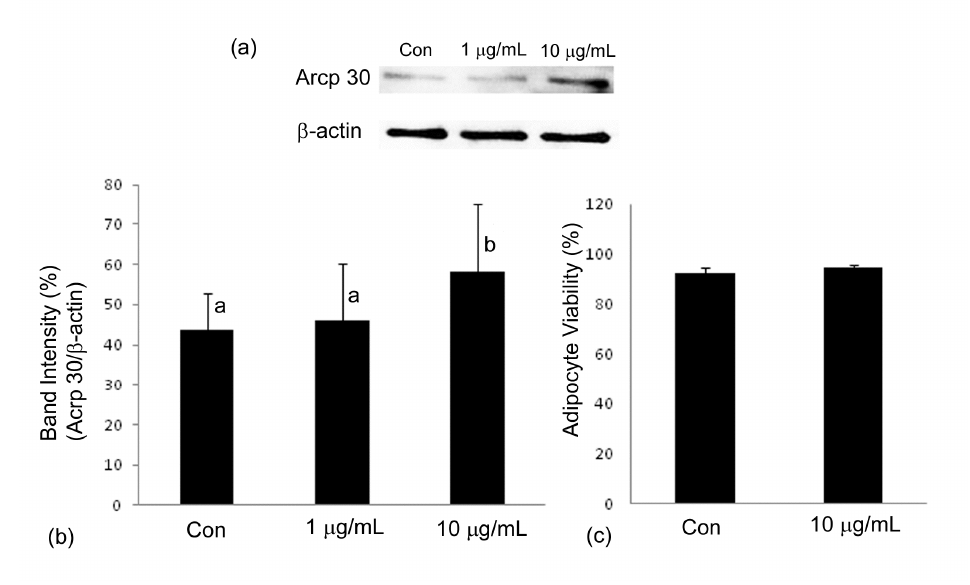
Figure 6 . The expression of adiponectin in adipocytes was assessed via Western blot analysis. Panel (a) shows the representative blots while panel (b) shows the densitometer quantification of adiponectin expression (acrp30) in 3T3-L1 adipocytes treated with PGE at 1 µg mL − 1 and 10 µg mL − 1 . Panel (c) shows the viability of the adipocytes at the end of the differentiation process with the highest concentration used for Western blot analysis. Values are expressed as mean ± SD of three independent experiments, as a percentage of β -actin density. Bars with a different letter are significantly different ( P < 0.05) from each